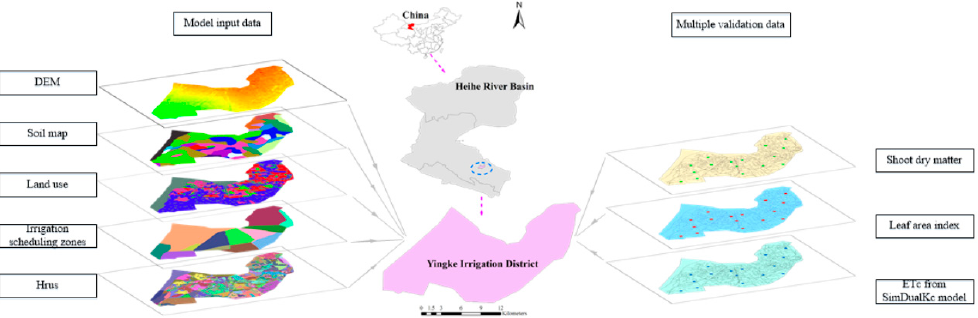
Figure 3. Model input data and multiple validation data. Table 1. Irrigation quota/irrigation scheduling in the Yingke irrigation district.